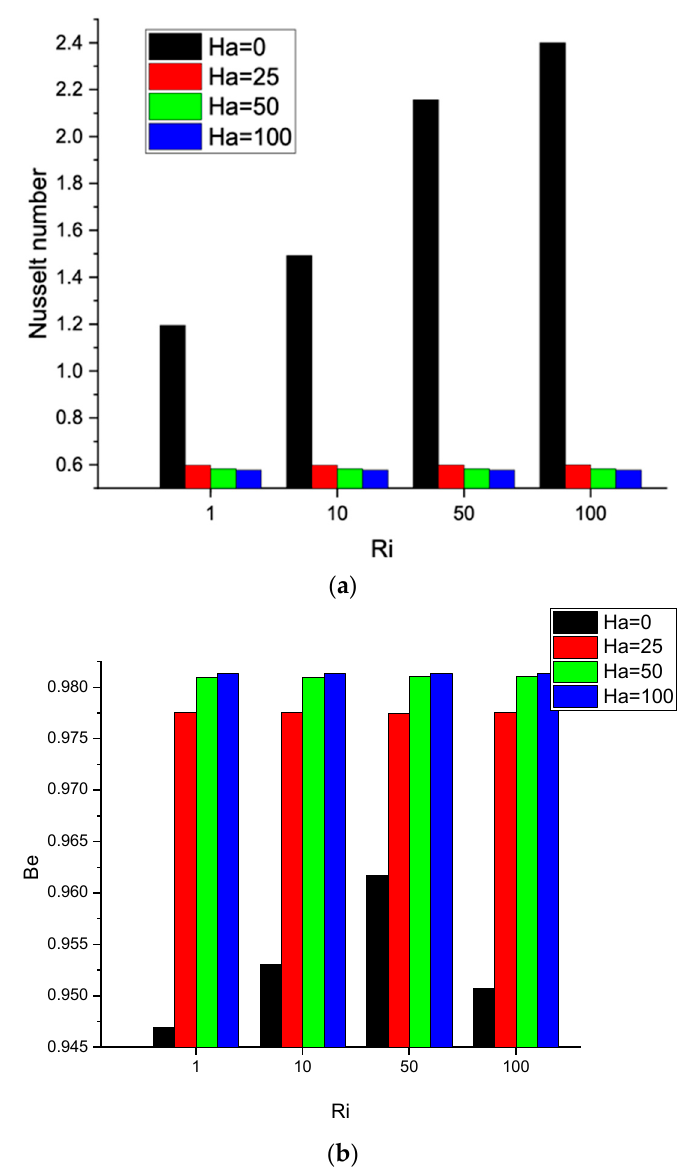
Figure 9. ( a ) Nusselt number: γ : 0°; N = 4; Ha = 0, 25, 50, 100; Ri = 1, 10, 50, 100; φ = 0.02; ( b ) Bejan number: γ : 0°; N = 4; Ha = 0, 25, 50, 100; Ri = 1, 10, 50, 100; φ = 0.02